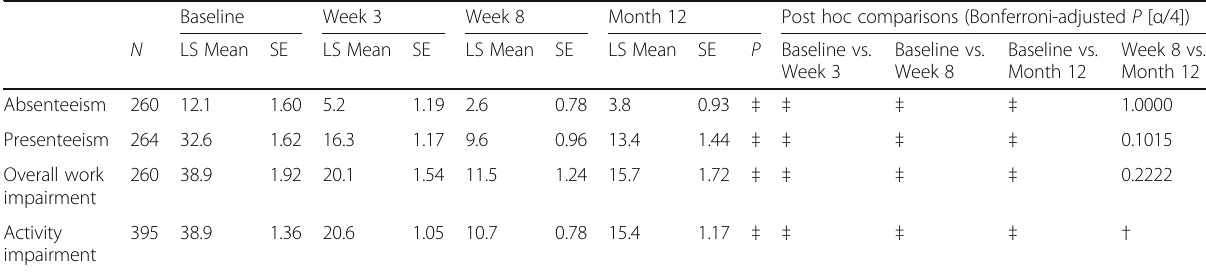
Table 5 WPAI:UC scores for the maintenance phase sample at acute and maintenance phase visits